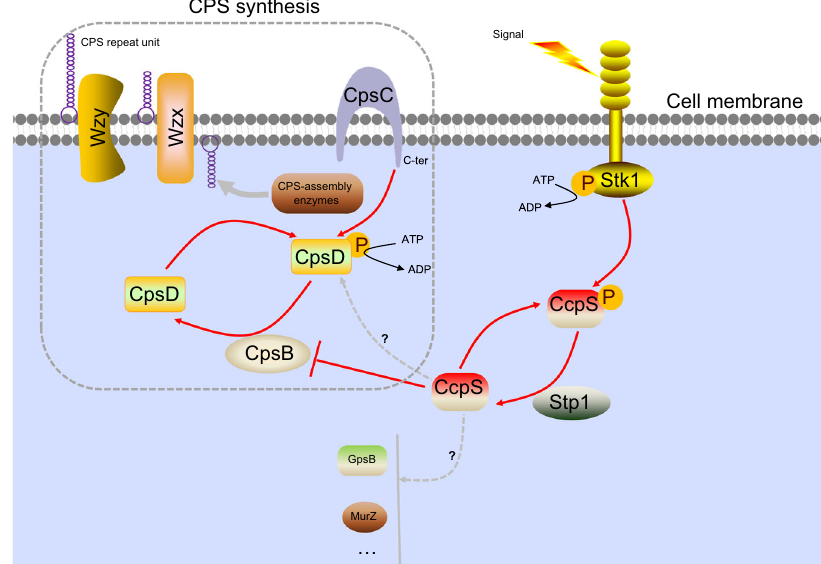
Fig. 8 | A model schematic depicting the mechanism of CPS synthesis coordi- nationbyCcpSphosphorylation. In S.suis ,CcpSisspeci fi callyphosphorylatedby the Stk1/Stp1 system. Non-phosphorylated CcpS inhibits CpsB activity. CpsB then modulates the phosphorylation levels of CpsD. CpsB and CpsD are the important components of the CpsBCD phosphoregulatory system in the Wzx-Wzy